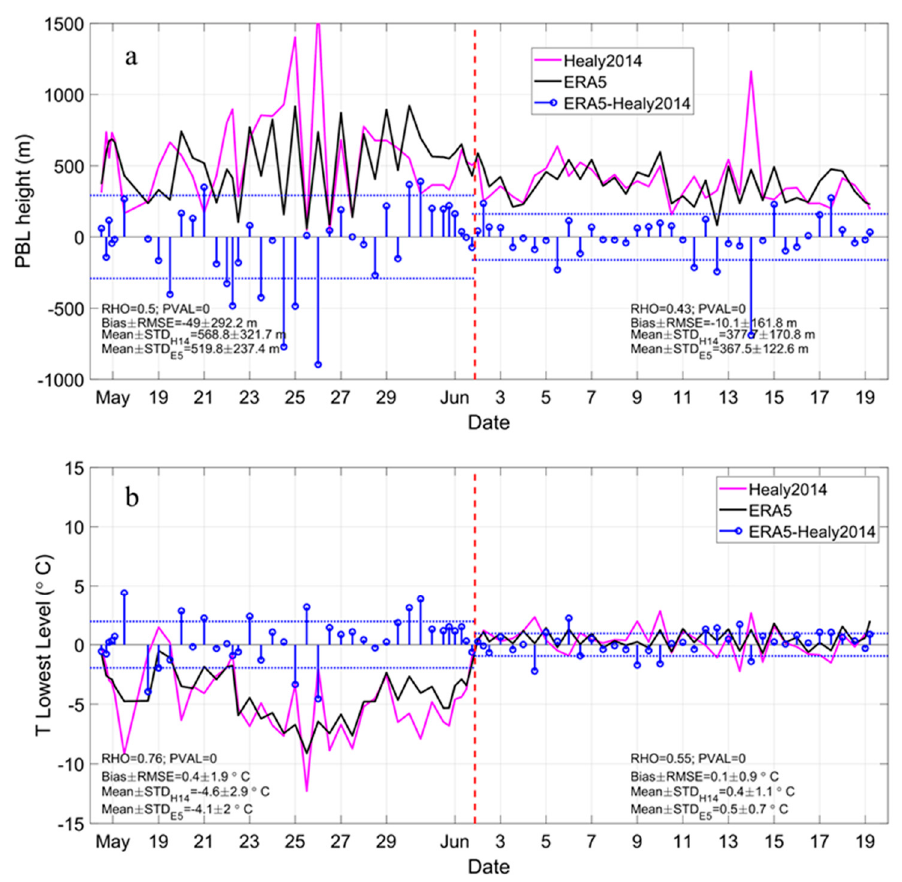
Figure 4. Planetary boundary layer heights ( a ) and the lowest level temperature ( b ) obtained from Healy 2014 (magenta lines) and ERA5 (black lines) data. The ball-and-sticks are the differences between the ERA5 and the observation. The horizontal dashed lines represent RMSE between ERA5 and observation in each period. The vertical dashed line divides the whole time into the cold period (information listed left) and the warm period (information listed right). RHO is the correlation coefficient; PVAL is the corresponding p-value which indicates the significance level of the hypothesis that no correlation exists; Bias is bias error; and RMSE is root-mean-square error.